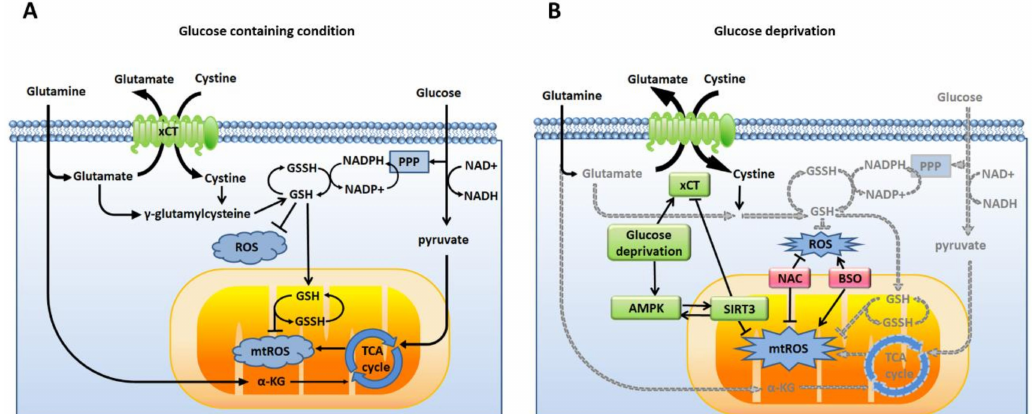
Figure 5. ROS mediate the xCT-related glucose dependency. ( A ) When nutrients are su ffi cient, cancer cells use glucose and glutamine to produce energy and antioxidants to balance the intracellular ROS and mtROS. ( B ) During glucose deprivation, the production of energy and antioxidants is decreased (gray). xCT upregulation promotes the import of cystine by exchanging glutamate. AMPK is also activated to regulate the antioxidant function of SIRT3. The knockdown of SIRT3 increases the expression of xCT, increases the ROS levels, and enhances the glucose dependency of cancer cells. The antioxidant N-acetyl-cysteine (NAC) is able to prevent glucose-deprivation-induced cell death. The glutathione biosynthesis inhibitor L-buthionine-S, R-sulfoximine (BSO) enhances glucose-deprivation-induced cell death. These results revealed that ROS are involved in xCT-related glucose